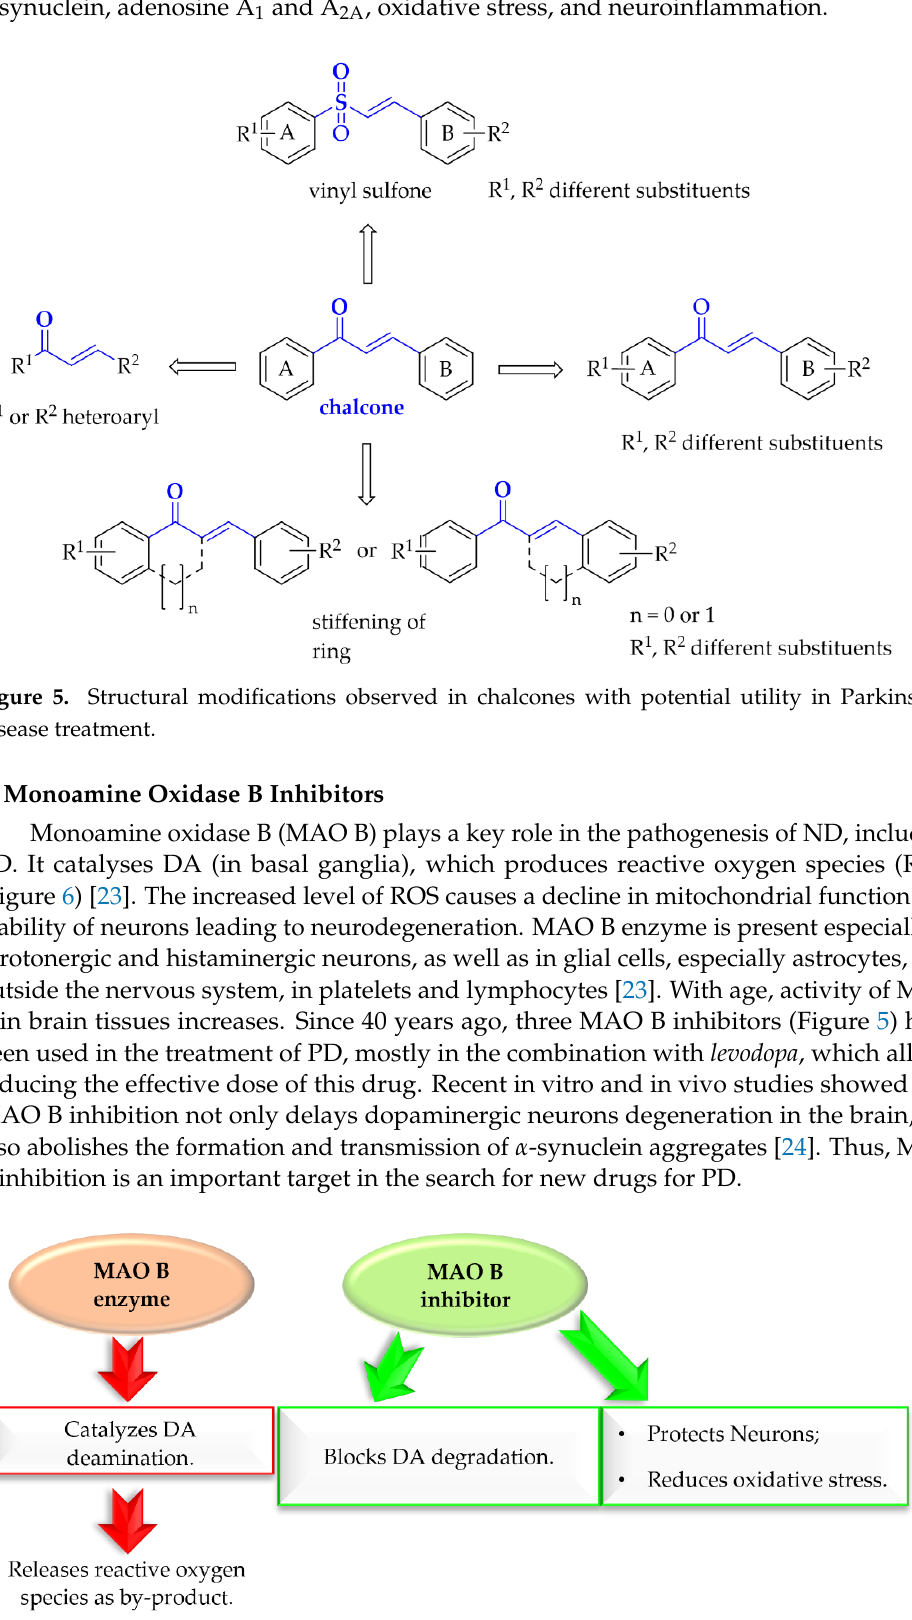
Figure 6. Effect of MAO B enzyme and MAO B inhibitor in Parkinson’s disease .